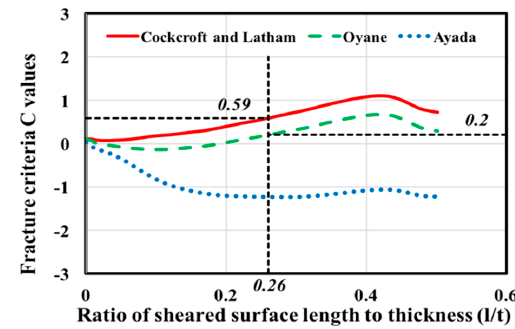
Figure 6. Relationships between fracture criteria ( C ) values and ratio of sheared surface length to thickness obtained by comparing the cutting surface by FEA with the shear limit point ( l/t ) obtained from the punching experiment for the punch diameter of 10 mm and a clearance of 18.75 %t. Each ( C ) value was calculated by comparing the cutting surface obtained by FEA with the shear limit point ( l / t ) obtained from the punching experiments under each condition. Figure 7 shows the relationships between the sheared surface length to thickness ratio and each ( C ) value. The increase in the ratio of sheared surface length to thickness increases the ( C ) values for the Cockcroft-Latham and Oyane models, and decreases for the Ayada model. Figure 8 shows the relationships between the clearance (%t) and ( C ) value.